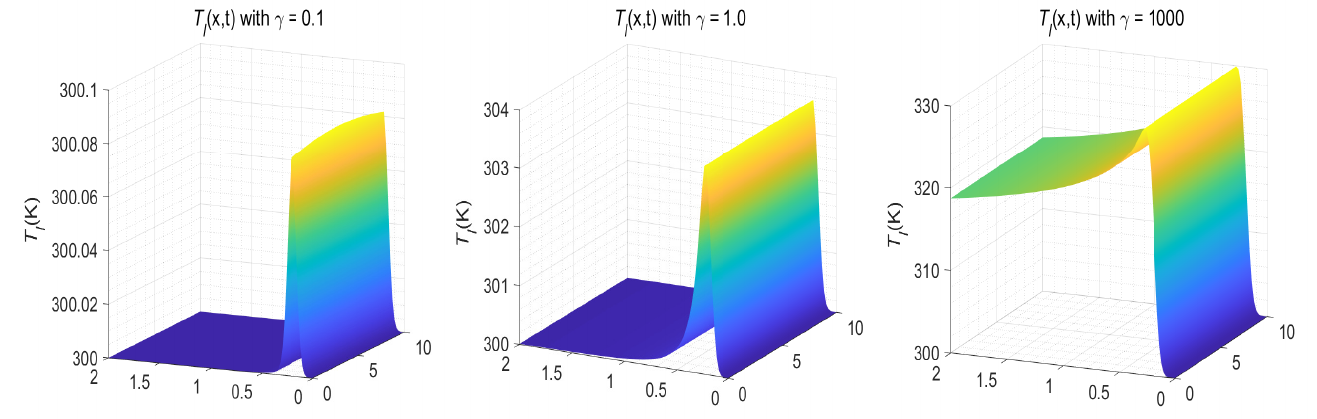
Figure 20. Temperature distributions of T l versus ( x , t ) with various γ when K n = 61.84658, ( α , β ) = ( 0.3,0.8 ) , N = 100, and M = 100 for Example 2.